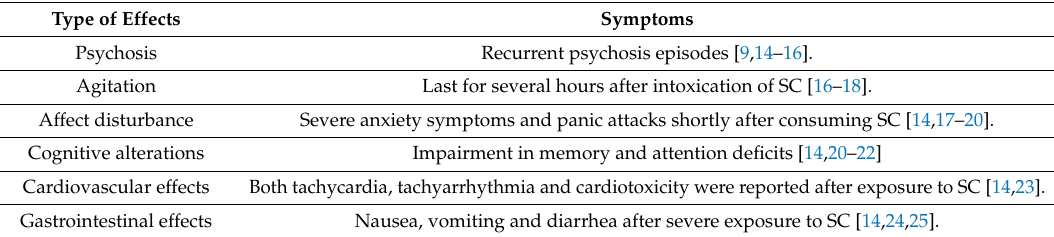
Table 1. Common clinical adverse effects induced after consuming synthetic cannabinoids.